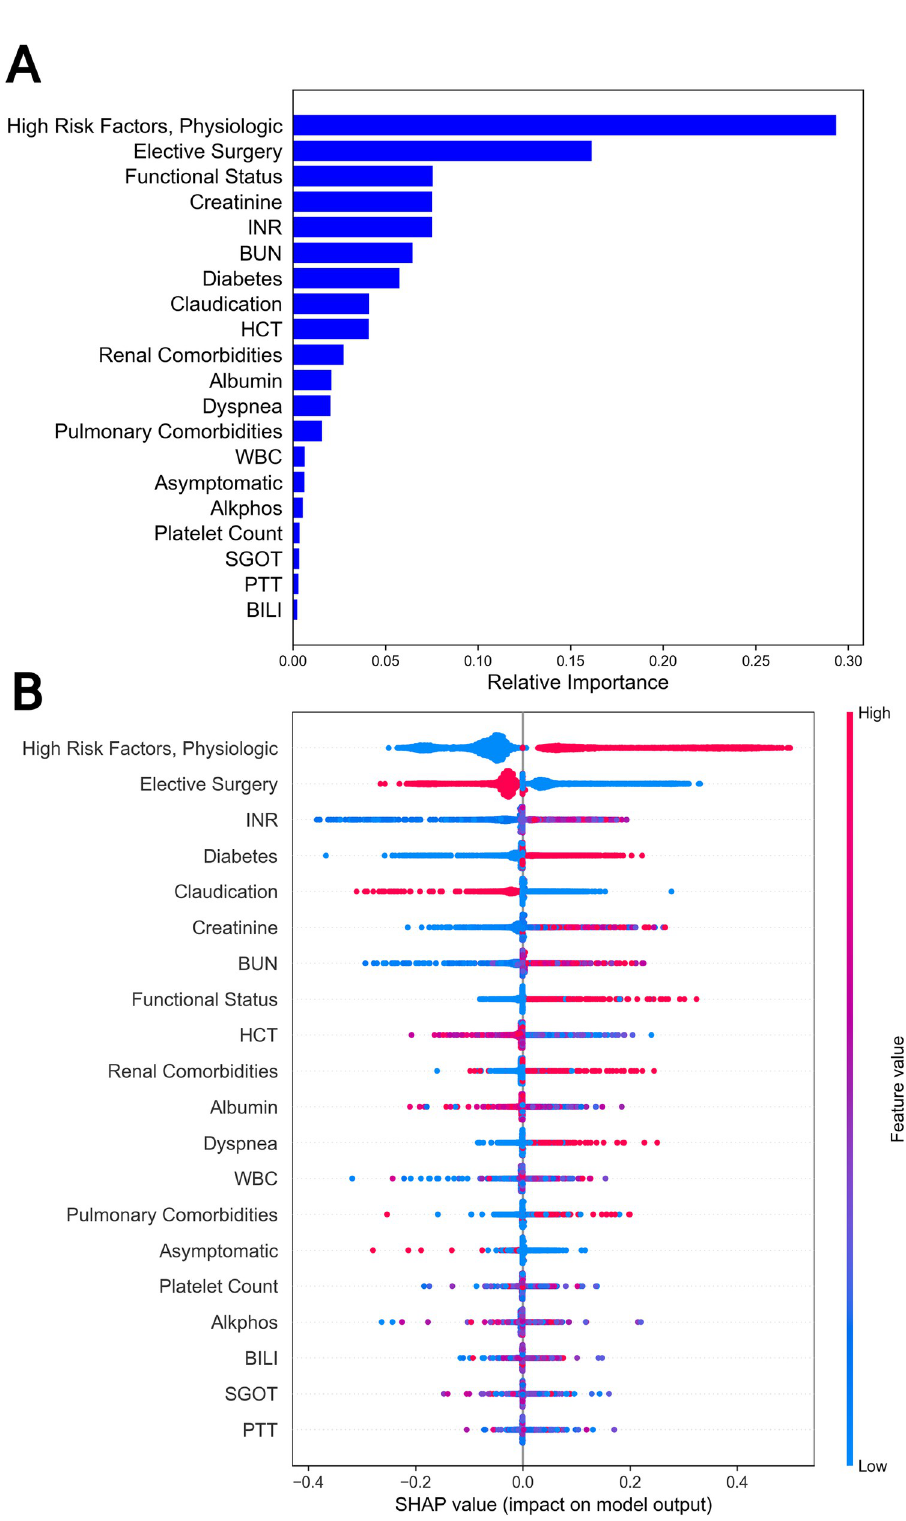
Fig 3. Gini impurity and SHAP scores for mortality. a) Gini impurity scores for features included in the 30-day mortality model. Higher values indicate increased effectiveness of features at separating those at risk of 30-day mortality from those not at risk of 30-day mortality. b) A Shapley summary plot. Color indicates feature value (red: High, blue: Low) and position.